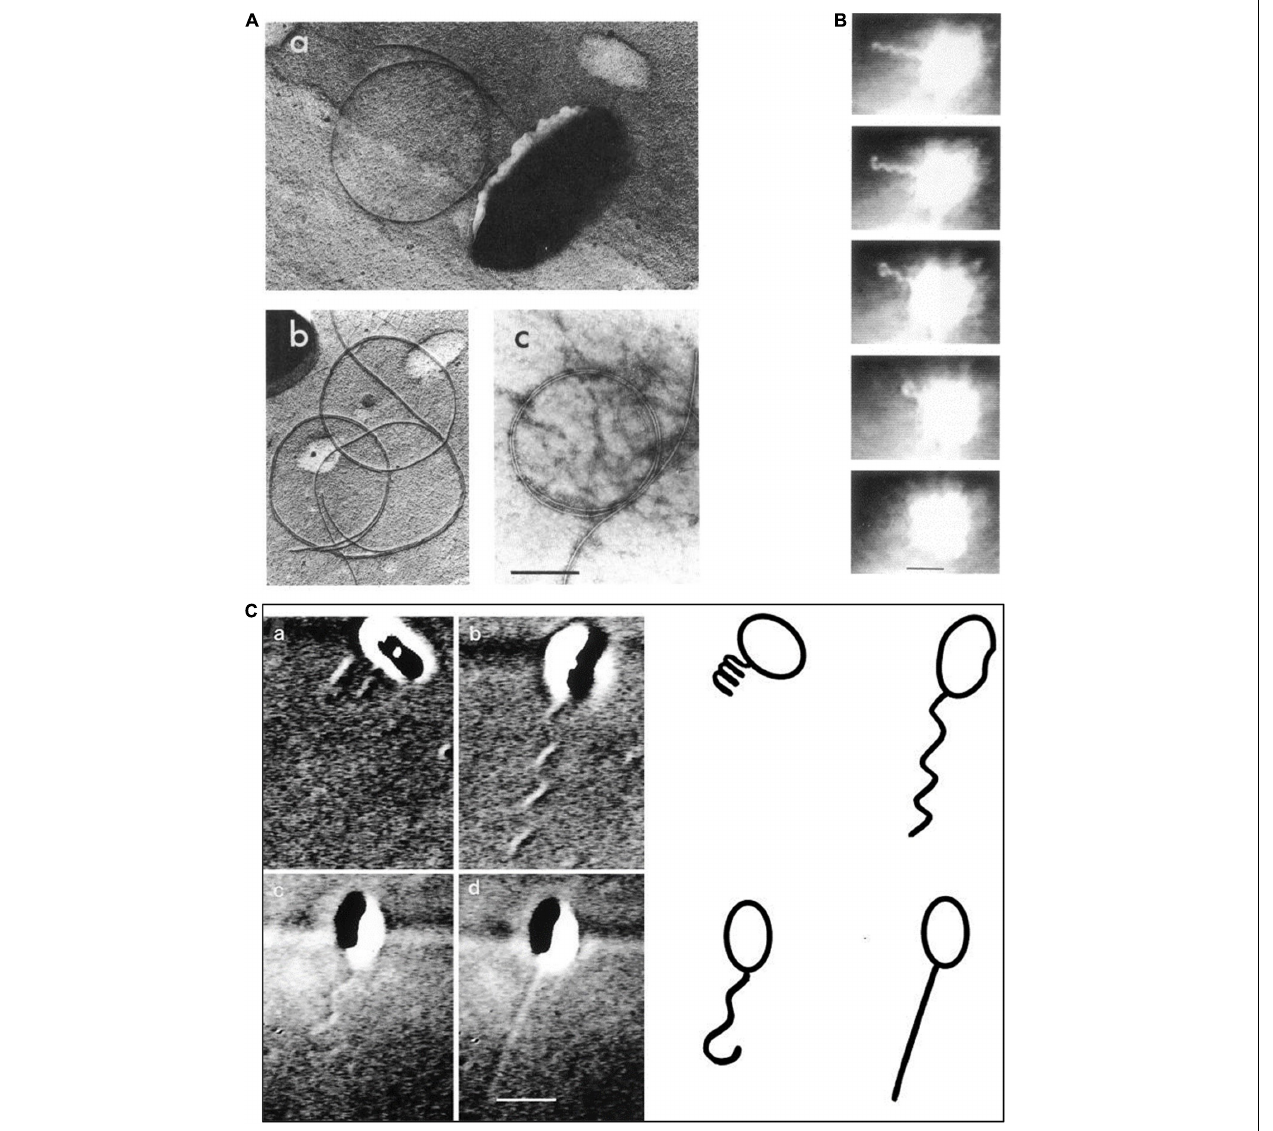
FIGURE 1 | Images of the Rhodobacter sphaeroides ( R. sphaeroides ) flagellum. (A) Various electron micrographs showing relaxed non-functioning filament. (B) Still images from dark-field light microscopy of swimming cell showing filament coiling against cell body after a stop. (C) Differential interference contrast (DIC) light microscopy images of swimming cells showing different conformations (a) coiled, (b) swimming, (c) starting to relax during a stop, and (d) fast rotating probably small amplitude filament. From Armitage and Macnab (1987) and Armitage et al. (1999) with